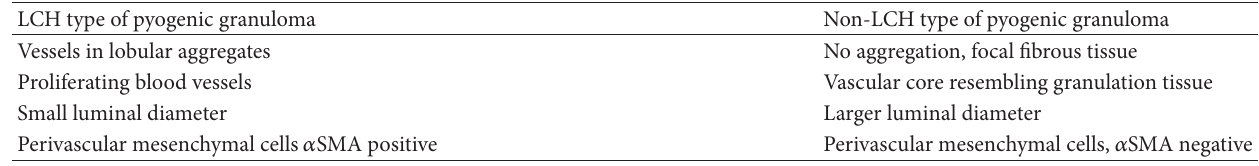
Table 2: Histopathological differences between LCH and non-LCH type of pyogenic granuloma. LCH type of pyogenic